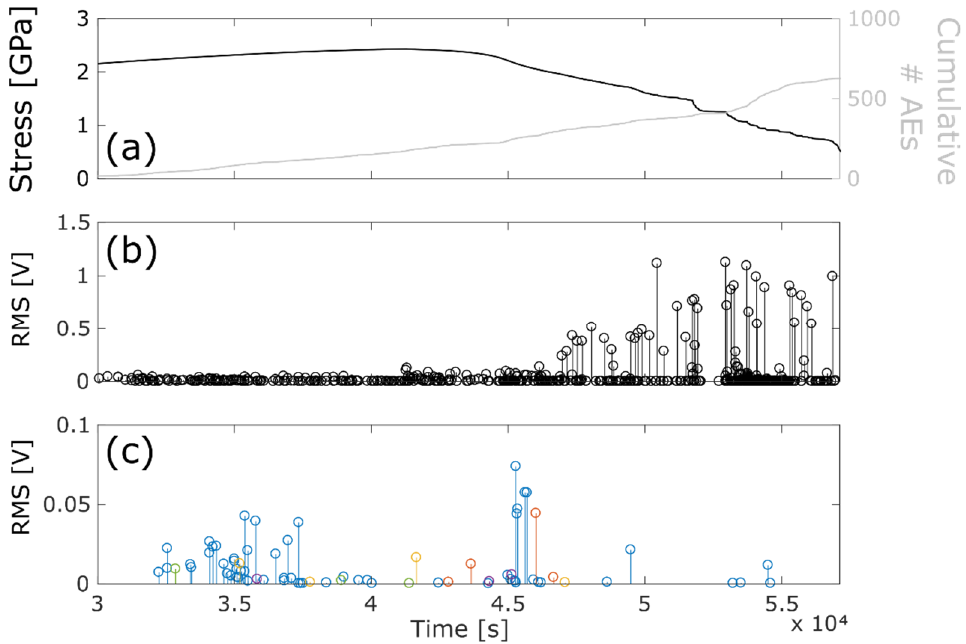
Figure 16. Results from AE clustering for experiment G23. ( a ) Shows the evolution of differential stress and cumulative number of AEs. ( b ) Shows the occurrence of AEs and their Root Mean Square values. ( c ) Shows only clustered